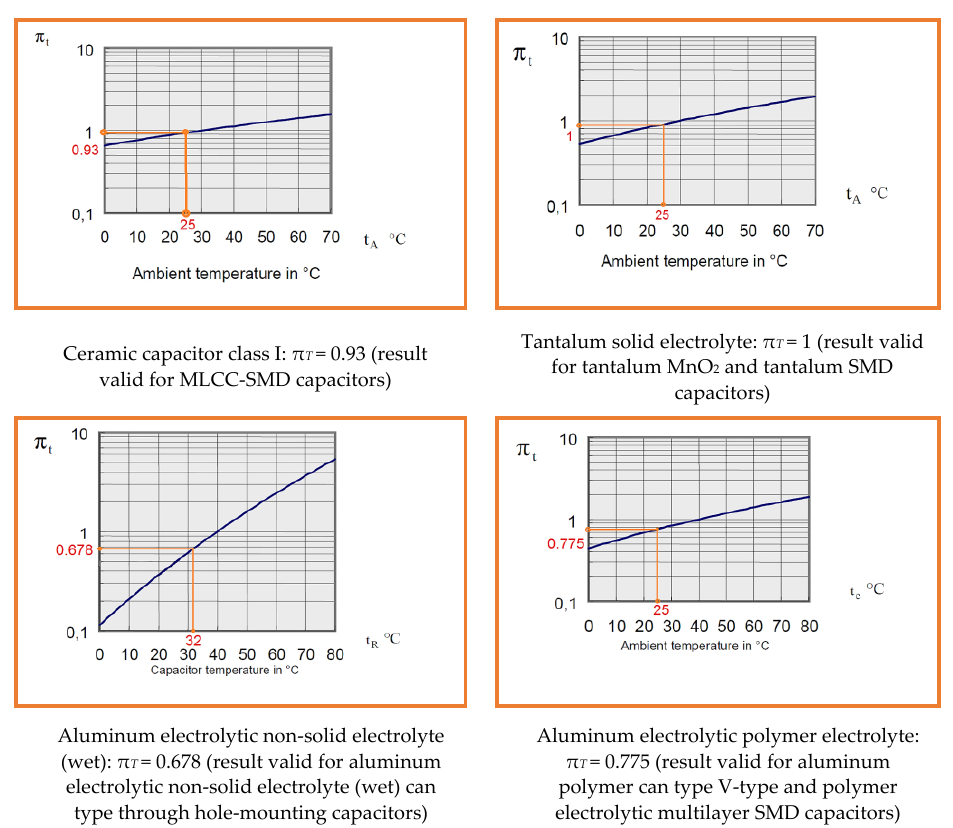
Figure 3. Temperature factor π T versus ambient temperature for ceramic class I, tantalum MnO 2 , tantalum polymer, aluminum electrolytic non-solid electrolyte (with T R = capacitor temperature, which is different from the ambient temperature if a current flows through the capacitor or if it is heated by a radiative environment such as a dissipating component; therefore, it is necessary to measure the case temperature), fixed plastic, polymer capacitor can-type, polymer electrolytic multilayer SMD (redrawn from IEC TR 62380 standard at 25 °C [17]).